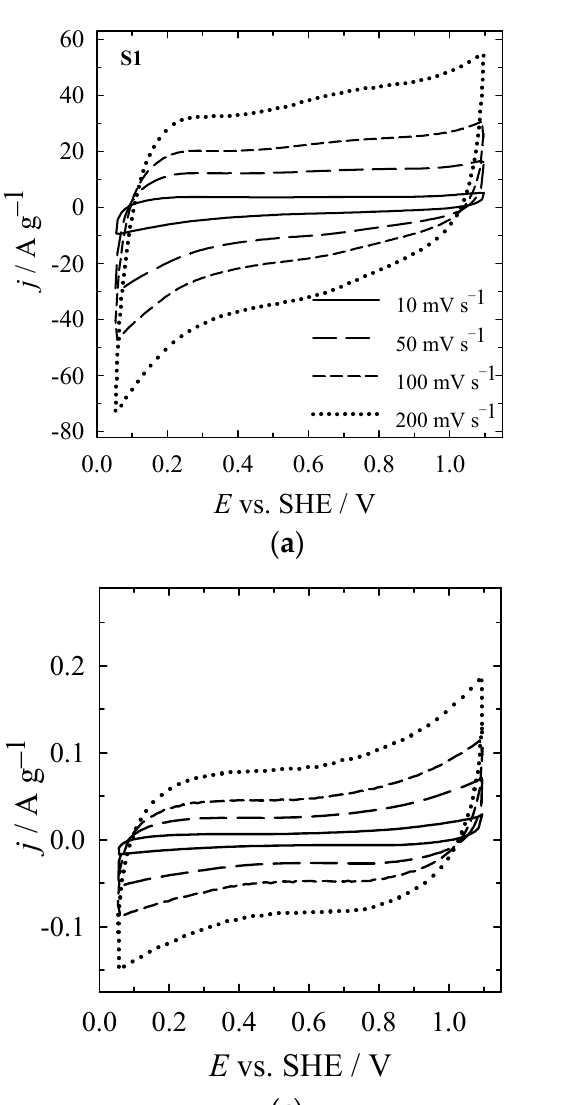
Figure 6. Specific capacitances of the sample S1, sample S2, and carbon obtained from CV curves. Comparisons of the supercapacitive behavior of various MnO 2 -based electrode materials reported in the literature and the present work are listed in Table 1, exhibiting the high specific capacitance of our prepared electrode materials. Table 1. Comparisons of specific capacitance for various MnO 2 -based electrode materials. Materials Scan Rate, mV s − 1 Specific Capacitance, F g − 1 Ref.